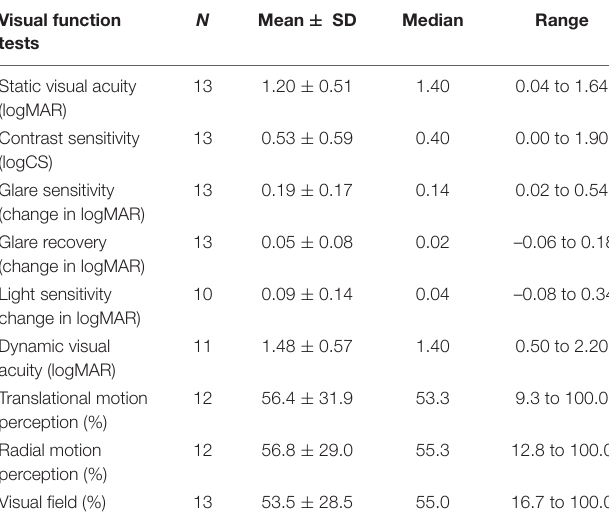
TABLE 3 | Summary of visual function assessments of Para alpine skiing participants. Visual function tests